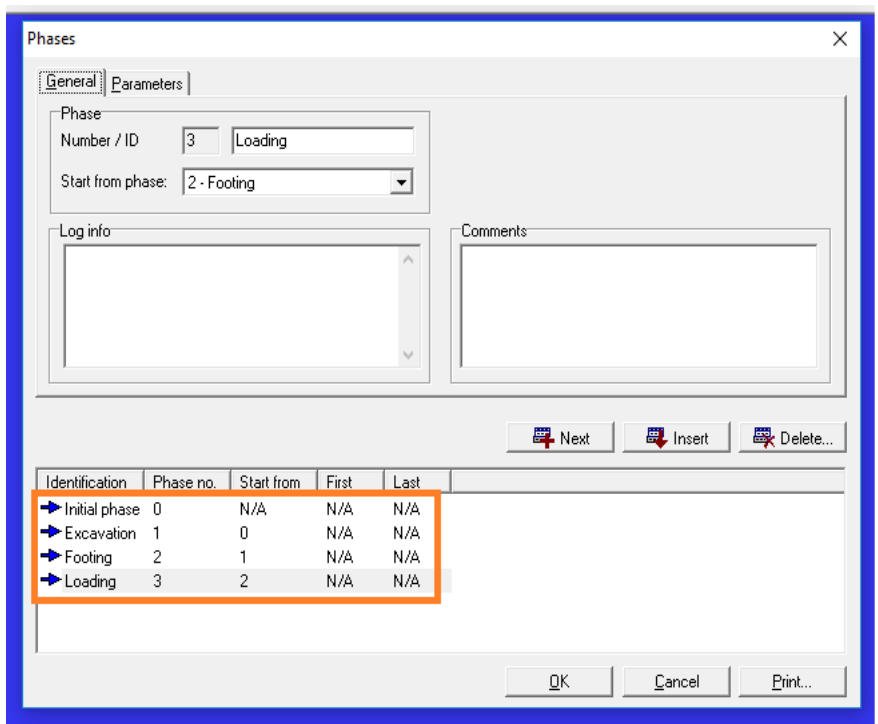
Fig. 10. Creating calculation